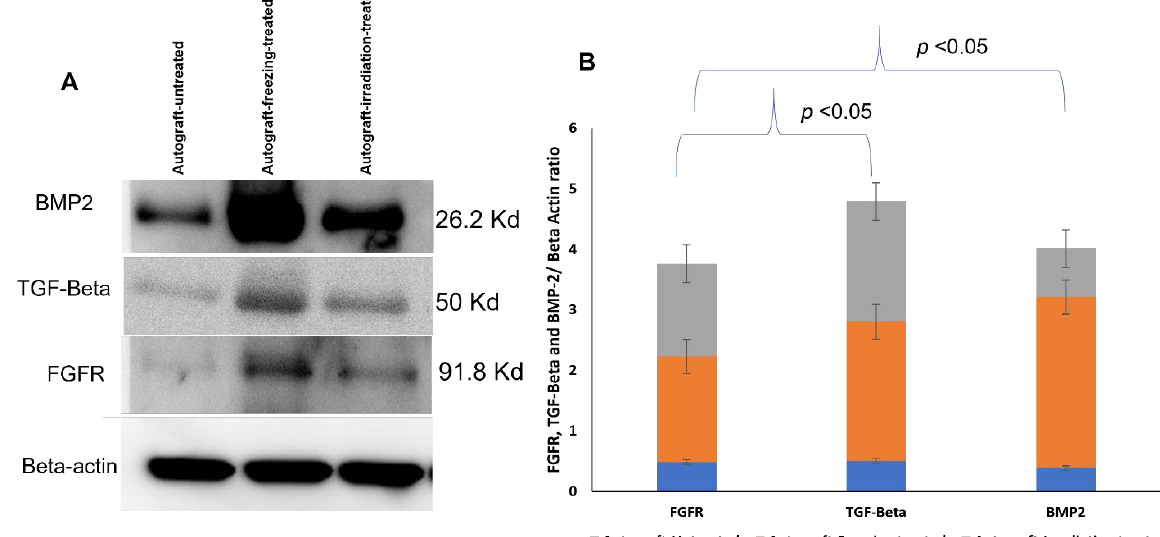
Figure 8. Validation of BMP2, TGF-Beta, FGFR expression levels using immunoblot analysis. ( A ) Immunoblot analysis of validating the BMP2, TGF-beta, and FGFR levels in autograft freezing treated samples compared to autograft untreated and the data was normalized using beta actin. ( B ) Bar chart showing the validation results of BMP2, TGF-beta, and FGFR comparing among treated and untreated autograft samples.